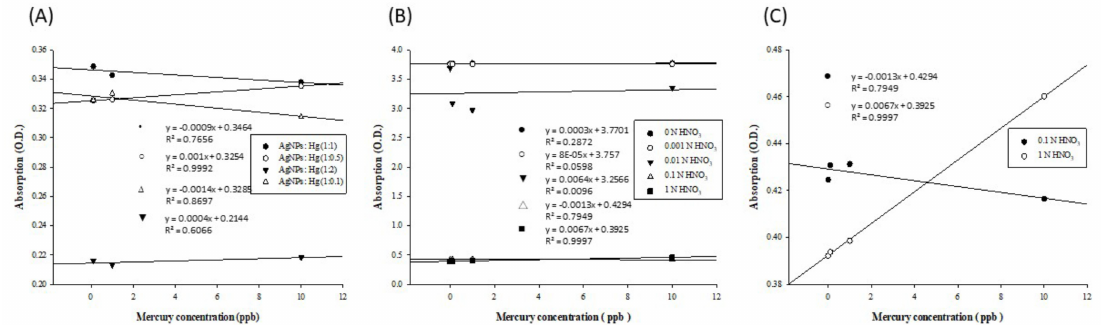
Figure 6. AgNP-based spectroscopic detection of mercury: ( A ) UV–Vis spectrum (at λ = 400 nm) for detection of mercury using silver nanoparticles in different reaction volume ratios. UV–Vis spectrum (at λ = 400 nm) for detection of mercury prepared with different nitric acid concentrations using silver nanoparticles; ( B ) three different concentrations of mercury prepared with five concentrations of nitric acid; and ( C ) mercury prepared with 0.1 and 1 N nitric acids. The 1 N nitric acid samples were the best of the five concentrations for diluted mercury standard solution for detection. The best R 2 value in the curves was obtained when adding 1 N of nitric acid with the